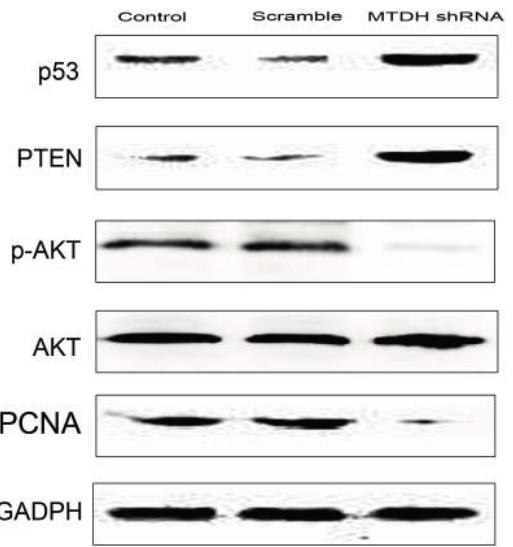
Figure 4. MTDH silencing effects on growth and apoptosis related protein